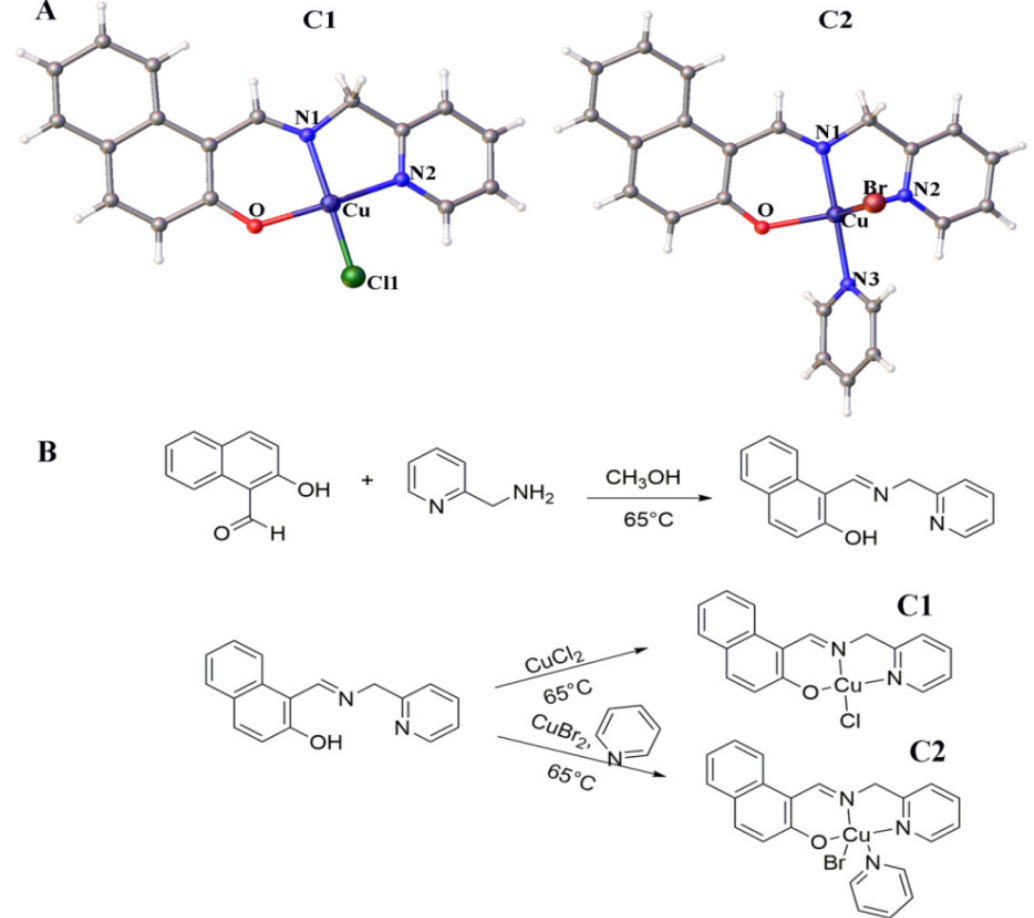
Figure 1. ( A ) Chemical structures of Cu 2+ compounds. ( B ) Synthetic routes of Cu 2+ compounds ( C1 and C2 ).